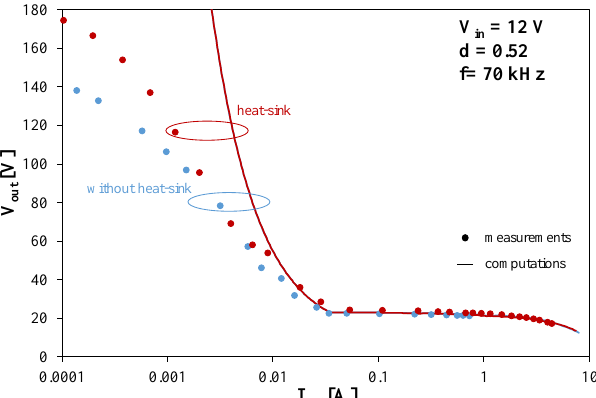
Figure 5. Measured and computed output characteristics of the boost converter for semiconductor devices operating at different cooling conditions.